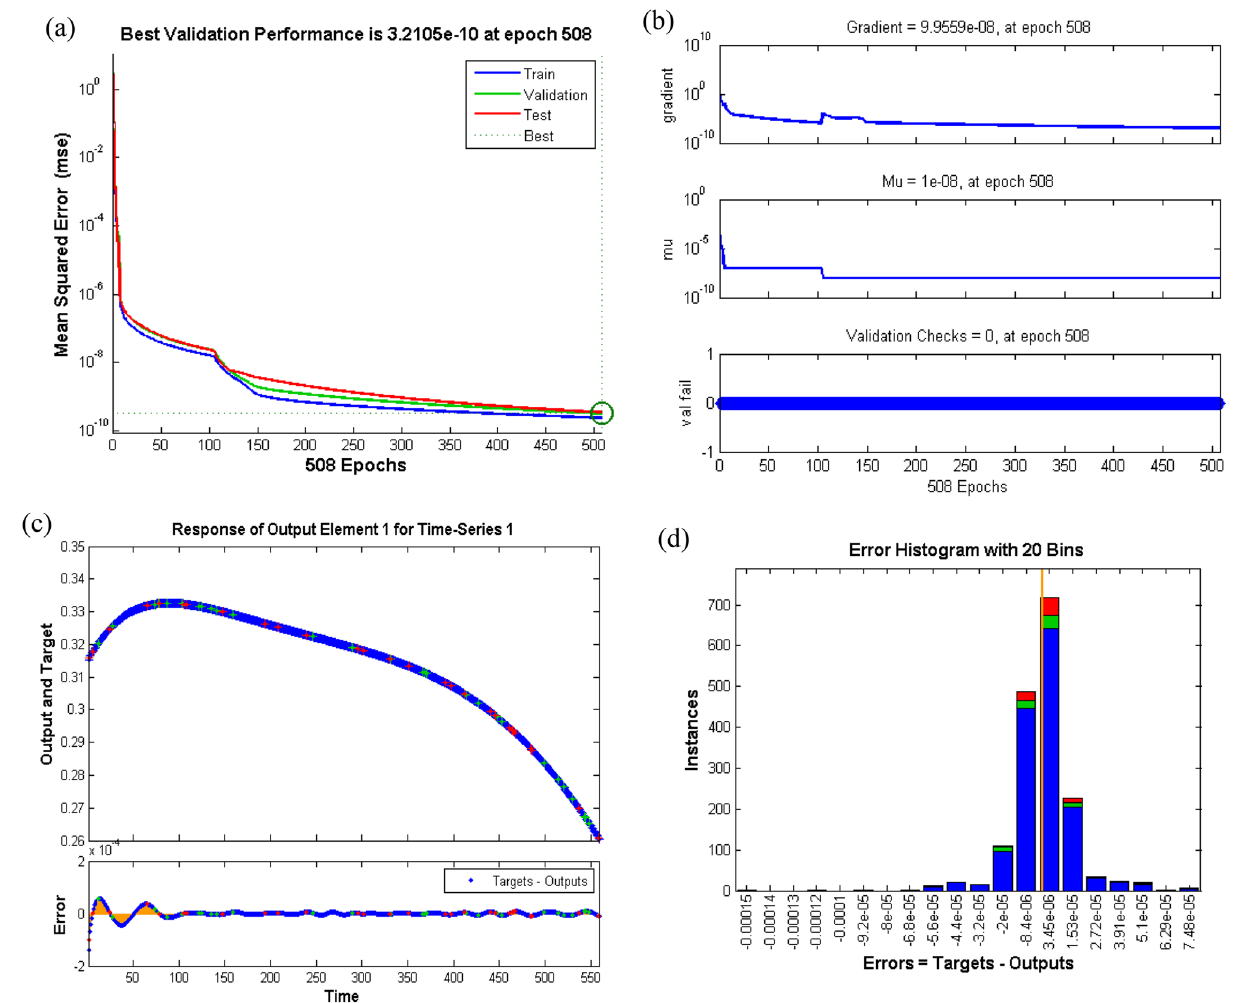
Figure 15. Performance curve of case study 2: scenario1 ( a ) learning curves of case 1, ( b ) training state of case 1, scenario 2, ( c ) time series response of case 1 and ( d ) error histogram for case 3.